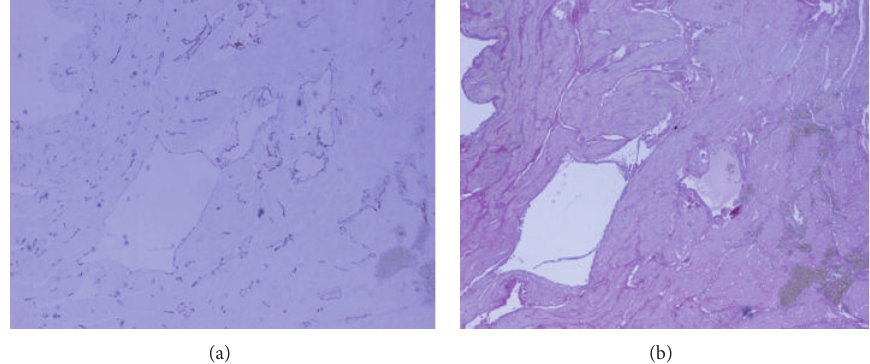
Figure 5: Histological examination showed numerous, variably sized, and thin-walled vessels distributed throughout the myometrium. The endothelialliningonthevesselwallwasconfirmedbystrongimmunoreactivityforCD31andCD34,andlackofelasticfiberlayerwasobserved by immunostaining with Elastica van